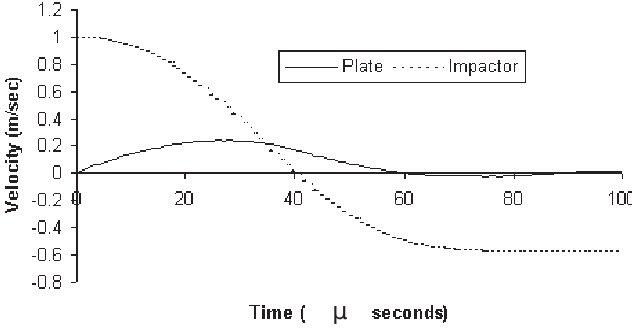
Fig. 5. The impactor velocity and the plate center velocity corresponding to Mesh